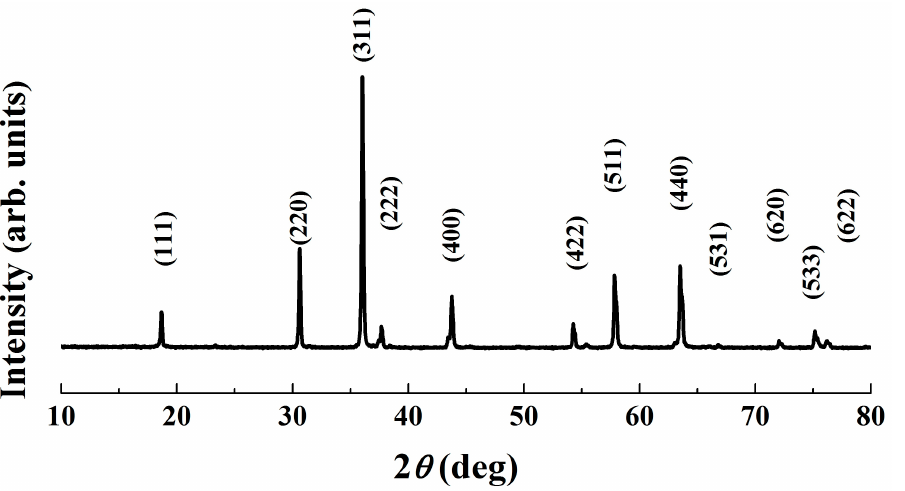
Figure 8. XRD patterns of bulk ceramic sintered at 1100 °C for 6 h.